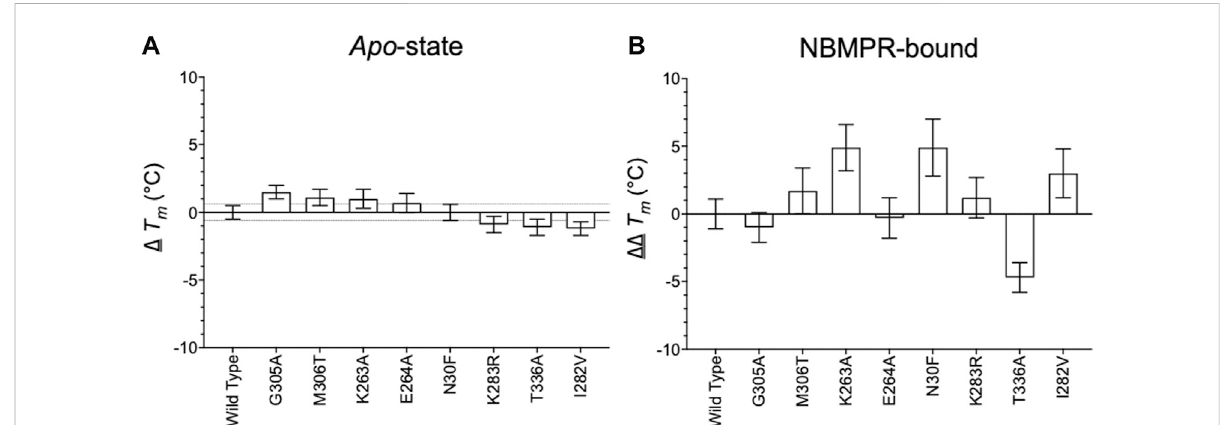
FIGURE 2 Relationof apo andNBMPR-boundhENT1variantstowild-type. (A) Δ T m ofallhENT1variantsinan apo -state,collectedasanaverageofatleast 3 repeats. The upper and lower bounds of the 0.6 ° C cut-off, as calculated by average SEM Δ T m , is represented by the dotted line. (B) ΔΔ T m of all hENT1 variants in an NBMPR-bound state, collected as an average of at least three repeats. Error bars are representative of error propagation as detailed in “ Methods and materials: Data- fi tting ” section. Please see Supplementary Figure S1 for full curves of apo -hENT1 variants.